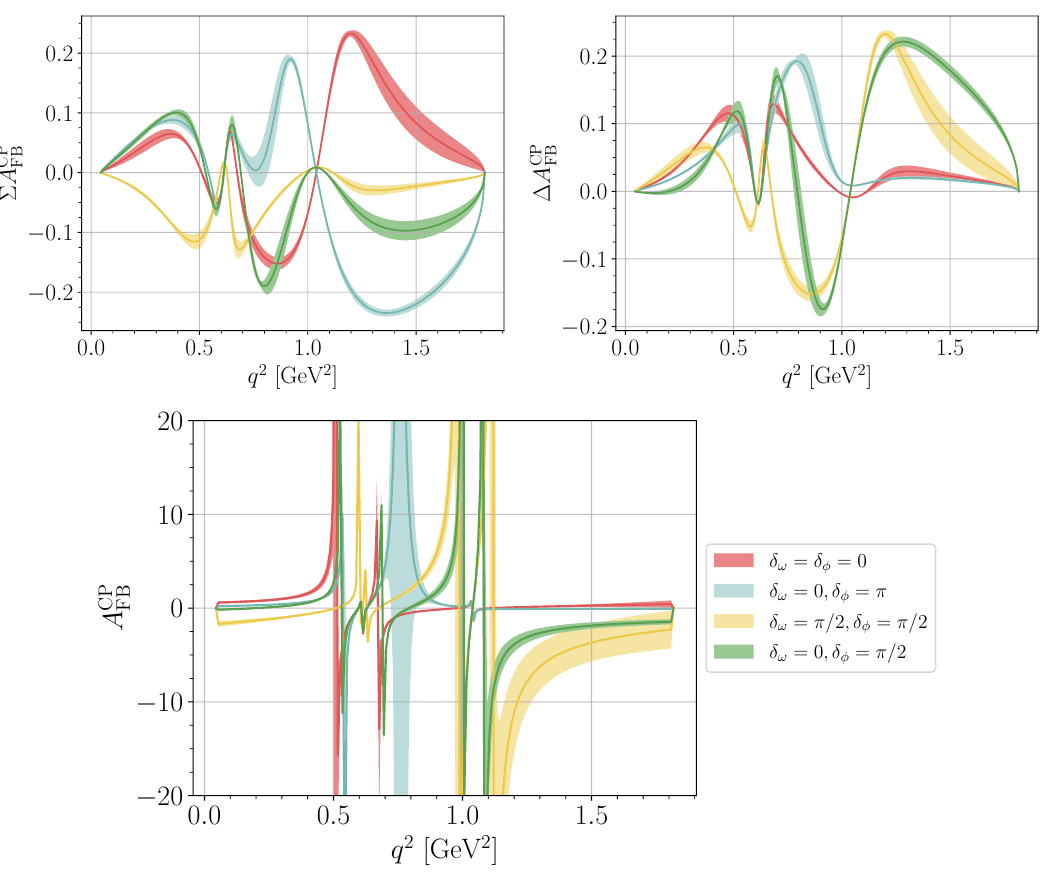
Figure 7 . CP-asymmetry of the forward-backward asymmetry in Λ c → pµ + µ − decays for C 10 = 0 . 5 e i π/ 4 scenario and different, fixed strong phases. The upper plots show the CP-average (left) and CP-difference (right) corresponding to eq. (5.7), the lower plot corresponds to their ratio eqs. (4.4),